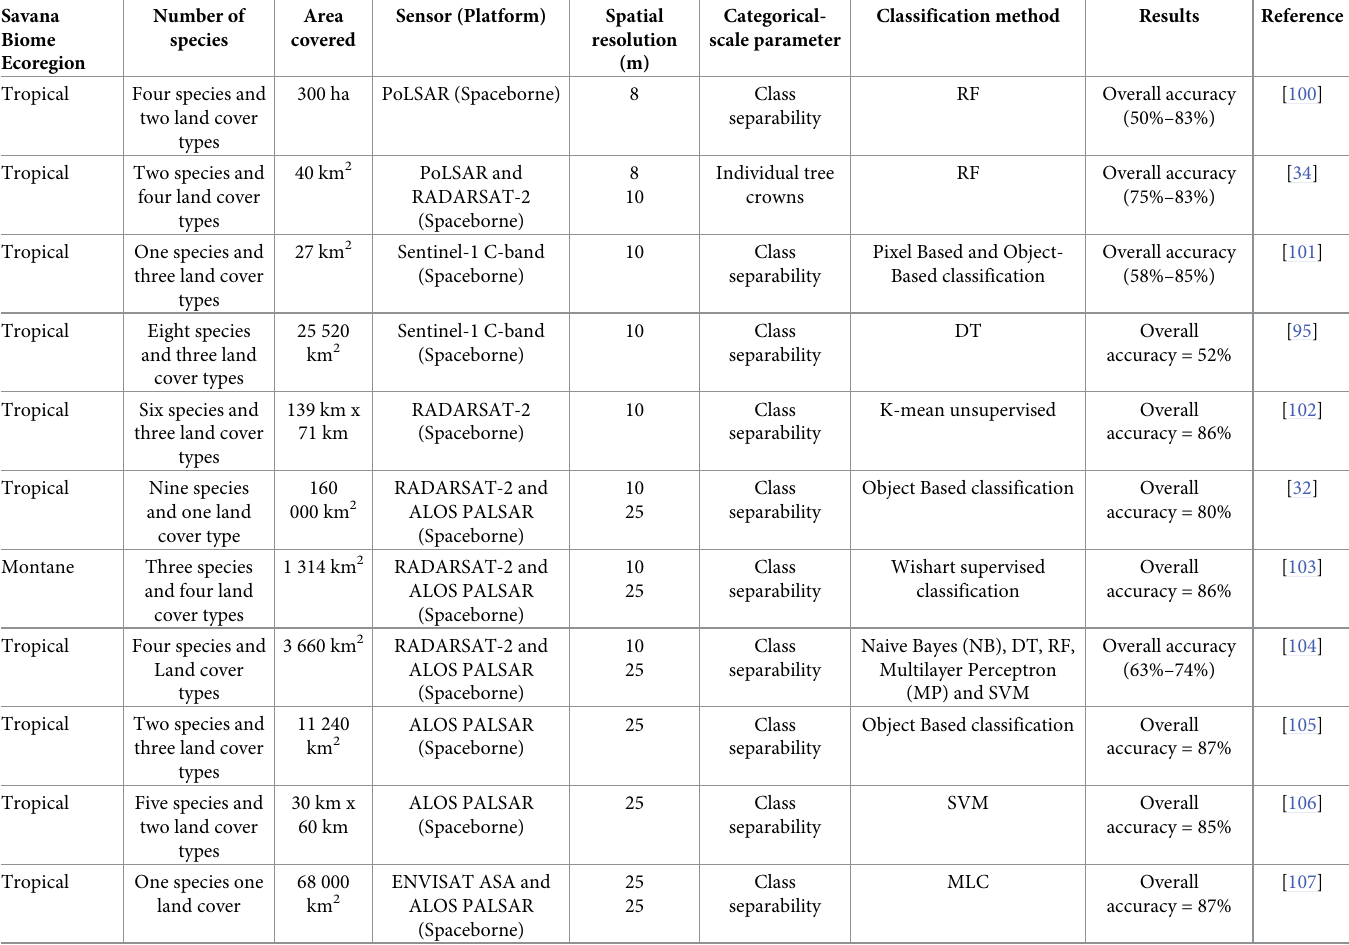
Table 2. Examples of studies that categorically classified woody plant species in savanna using RADAR remote sensing. Savana Biome